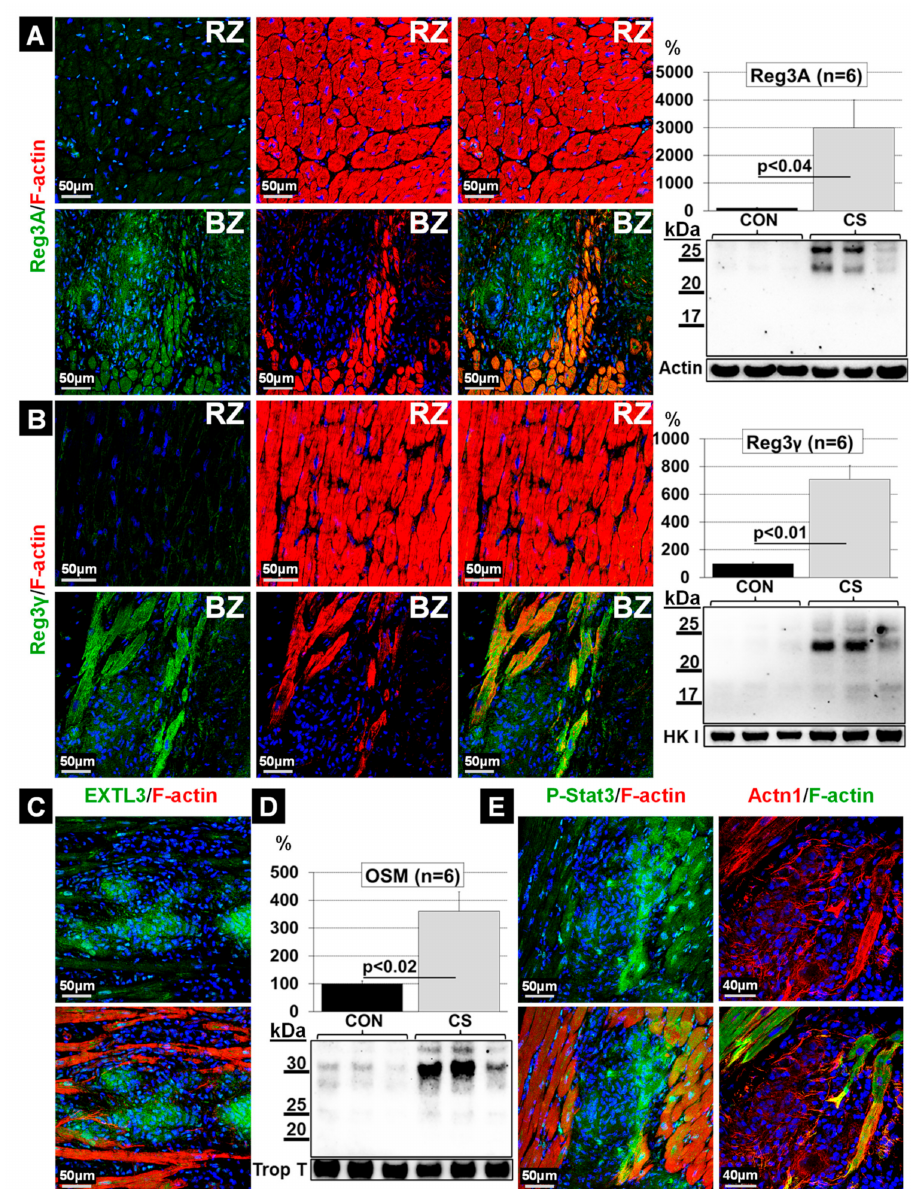
Figure 6. Increases in oncostatin M (OSM) correlate with elevations of the macrophage chemokines Reg3A and Reg3 γ in the border zone. Myocardial tissue from six control patients (CON) and six patients with cardiac sarcoidosis (CS) were analyzed by Western blotting (WB) and immunofluores- cence (IF). Troponin T (Trop T), actin and hexokinase I (HK I) serve as loading controls. ( A ) WB and IF images of Reg3A. ( B ) WB and IF images of Reg3 γ . ( C ) IF demonstrates EXTL3 (a potential Reg receptor)-positive granulomata. ( D ) WB of OSM. ( E ) IF images of activated cardiomyocytes (P-Stat3, Tyr705). IF images show dedifferentiated non-muscle α -actinin 1 (Actn1) expressing cardiomyocytes in the BZ as well as the elongated and sharp shape of cardiomyocytes indicate furthermore OSM activity. The nuclei are stained blue with